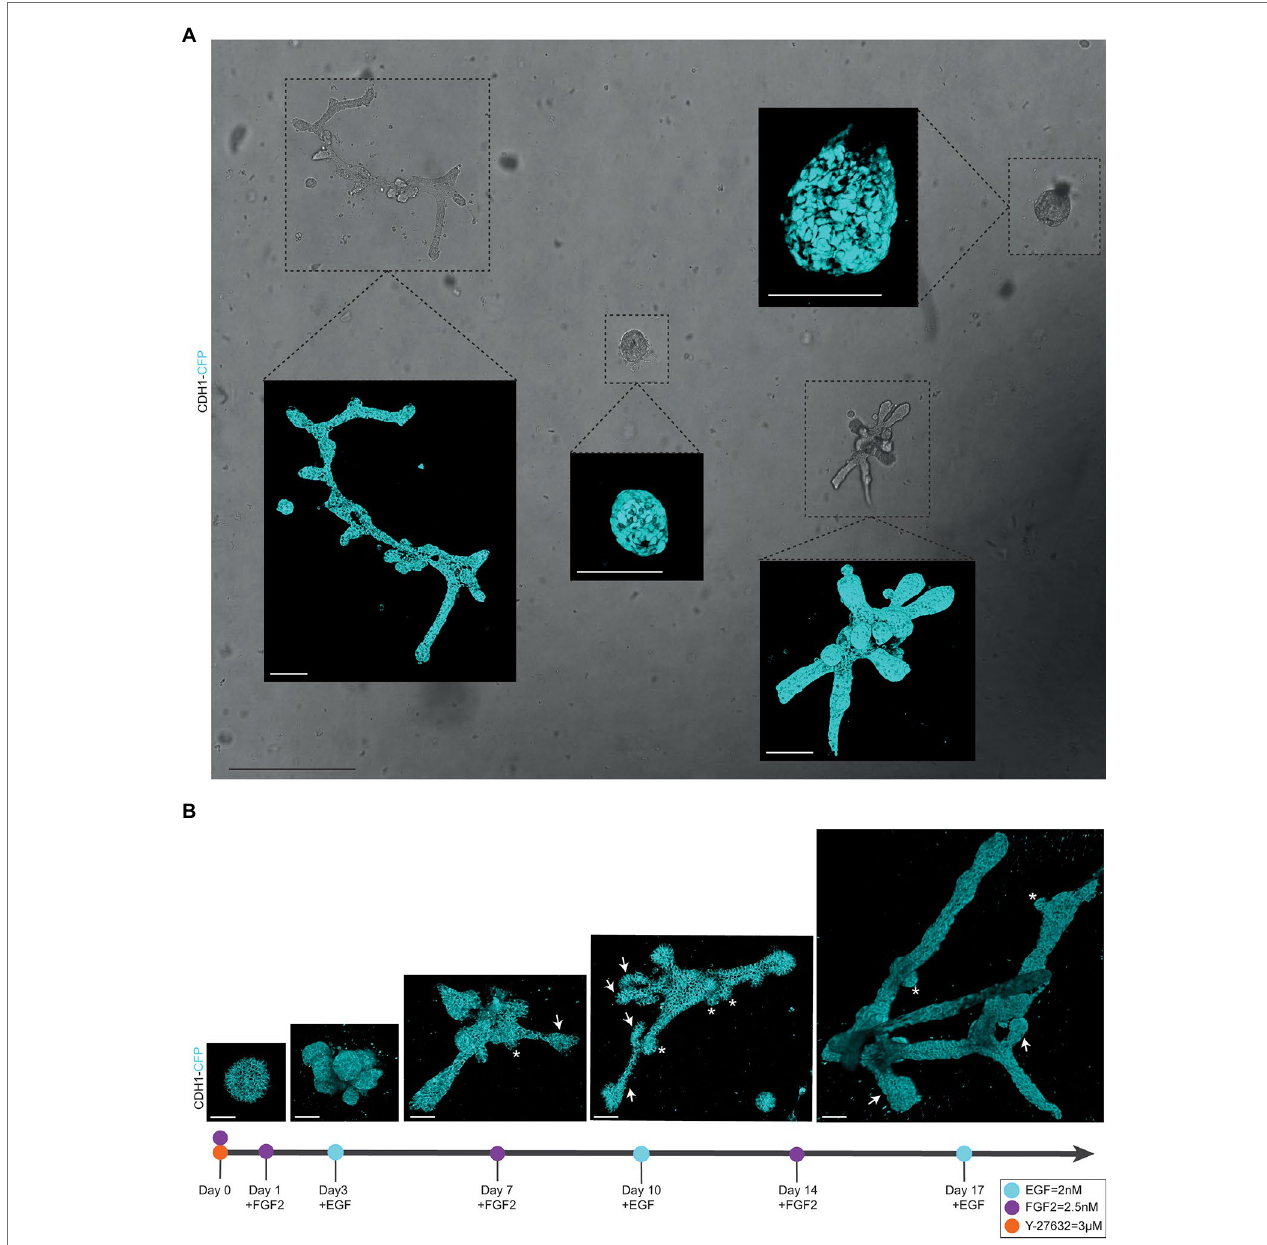
FIGURE 2 | Alternating culture conditions in 7B3C gels result in branched mammary organoids. (A) Overview scan of mammary spheres and branched organoids used to retrace the same organoids over time based on their location within the culture well (brightfield image). Insets depict confocal images of Cdh1-CFP signal (cyan) of the individual organoids (3D rendering). Scale bars represent 500 μ m for the brightfield image and 100 μ m for the confocal images. (B) Representative 3D multiphoton images of Cdh1-CFP (cyan) organoid structure over time during the main morphogenetic changes occurring in 7B3C under alternation treatment. Budding structures (<70 μ m) are indicated with white asterisks; branches (>70 μ m) are indicated with white arrows. Scale bars represent 50 μ